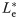
The LSE Le* is insensitive to the geometric distribution factor λ > 0 and to Ch ≫ 1.This implies that for a wide range of values of λ and Ch the LSEs are insensitive to the HSC configuration {hi}. (a) Le* s found at each value of λ. (b) Averages and standard deviations (error bars) of MSE (Le*) as a function of λ. The LSE and MSE(Le*) values associated with self-consistently using {hi}/H+={y^i} from experimental data are marked by arrows and “exp.”